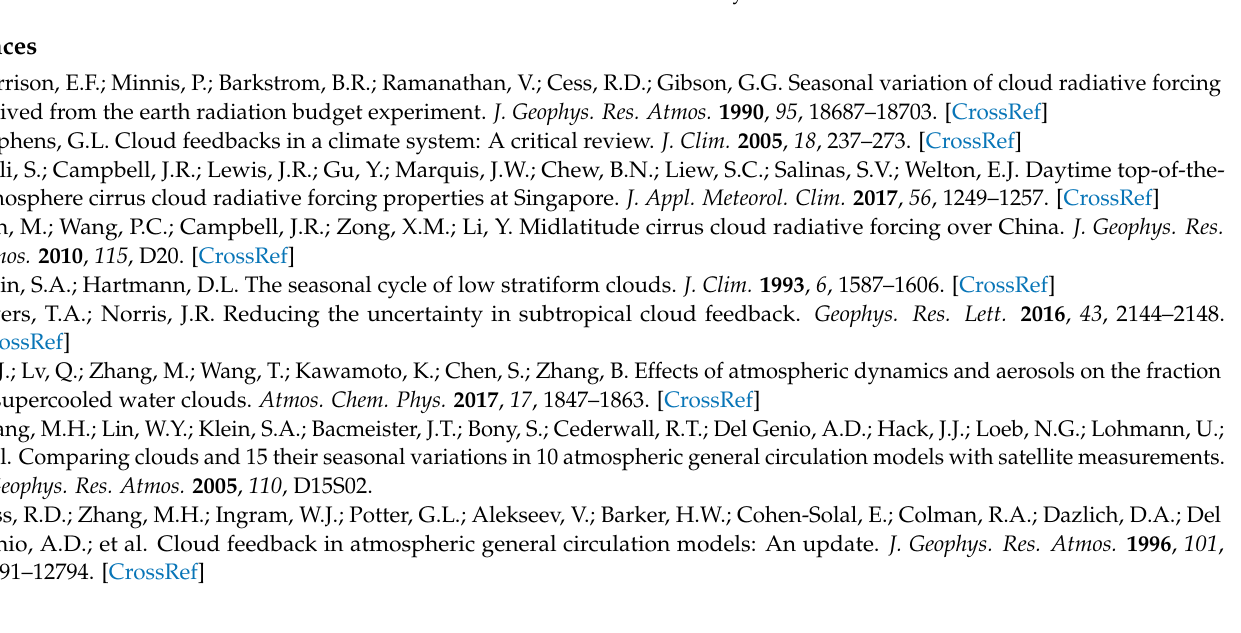
Figure S2: Four-year CRE of different cloud phases over the TP, Figure S3: Four-year CRE of different cloud phases at TOA, ATM, and SFC over the TP, Figure S4: Four-year cloud radiation contribution of different cloud phases at TOA, ATM, and SFC over the